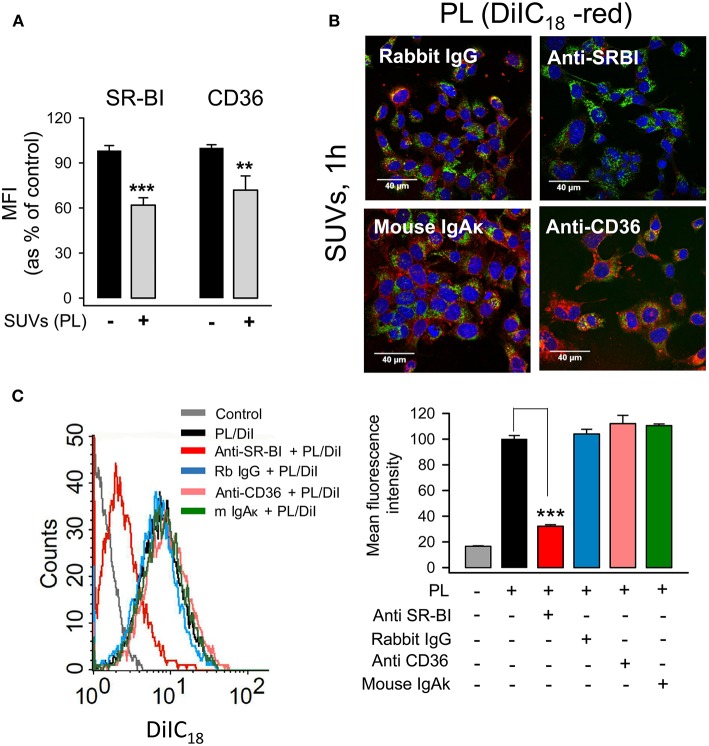
SR-BI mediates endocytosis of small surfactant vesicles by pneumocytes. (A) MLE-12 cells were incubated in the presence or absence of SUVs (250 μg PL/ml) for 2 h, then cells were harvested and stained with anti-SR-BI, anti-CD36 or their respective controls, rabbit IgG or mouse IgAκ, and appropriate Alexa Fluor 488-conjugated secondary antibodies. The mean fluorescence intensity (MFI) of SR-BI and CD36 was measured by flow cytometry, and background fluorescence from IgG and IgAκ controls was subtracted. Data are presented as mean ± SEM of two independent experiments run in triplicate. Student's t-test was used. **p < 0.01, and ***p < 0.001 when compared with control cells in the absence of lipids. In (B,C), anti-SR-BI and anti-CD36 blocking antibodies or their respective controls, rabbit IgG or mouse IgAκ, were added to MLE-12 cells for 30 min. Then cells were incubated with DiIC18(3)-labeled SUVs (100 μg/ml) for an additional 60 min. (B) Cells were fixed, stained with Alexa Fluor 488-WGA (cell membranes) and DAPI (nuclei), and analyzed by confocal microscopy. (C) Cells were fixed and analyzed by flow cytometry. A representative histogram is shown. The mean fluorescence intensity is represented as percentage of positive control, which is cells incubated with DiIC18(3)-labeled SUVs in the absence of antibodies. Data are presented as mean ± SEM of three independent experiments run in triplicate. ANOVA followed by the Bonferroni multiple-comparison test was used. ***p < 0.001 when compared with cells incubated with SUVs in the absence of antibodies.